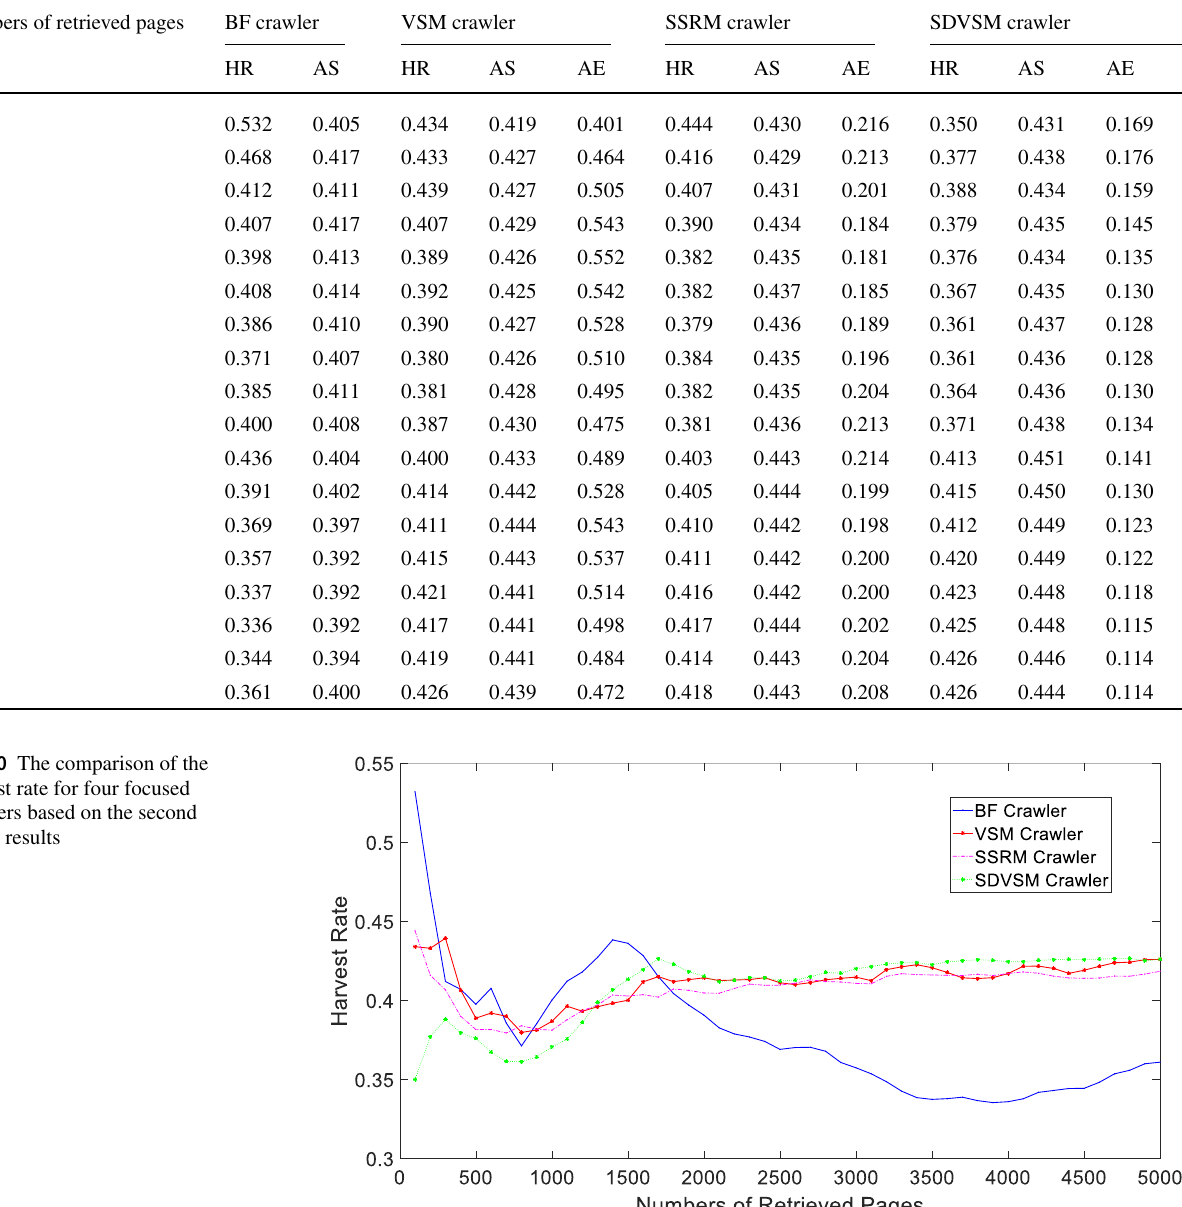
Table 5 The second group results including HR, AS and AE for four focused crawlers